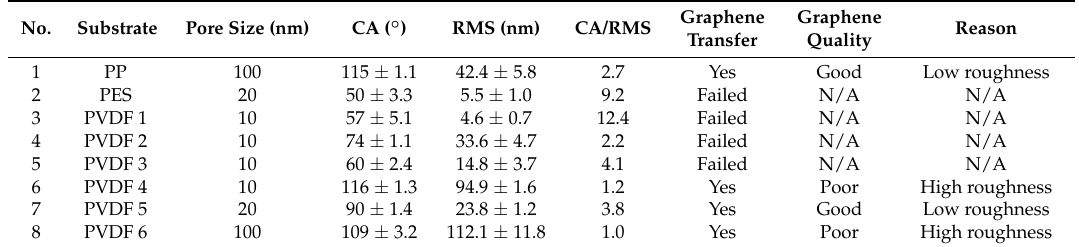
Table 2. Summary of Graphene transferability onto different polymeric substrates.